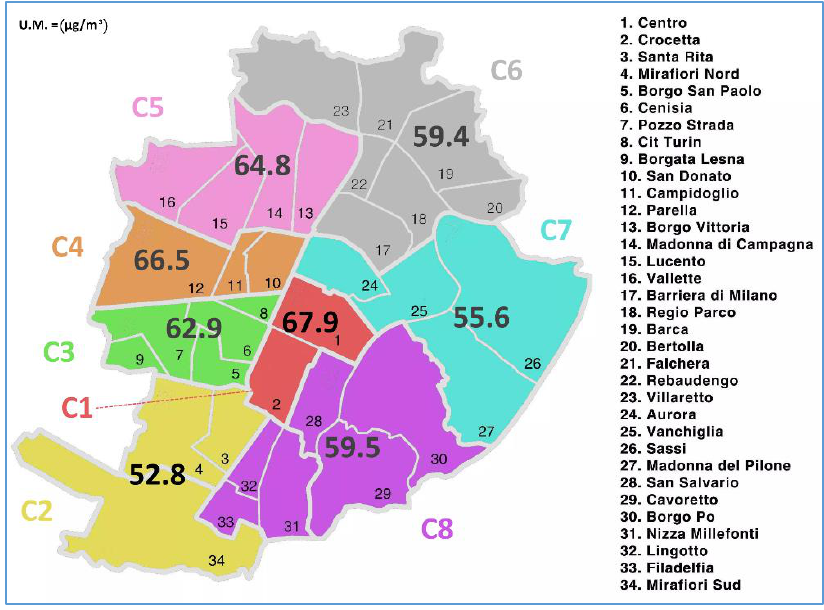
Figure 6. Map of NO 2 concentrations by “Circoscrizioni” for the campaign period.